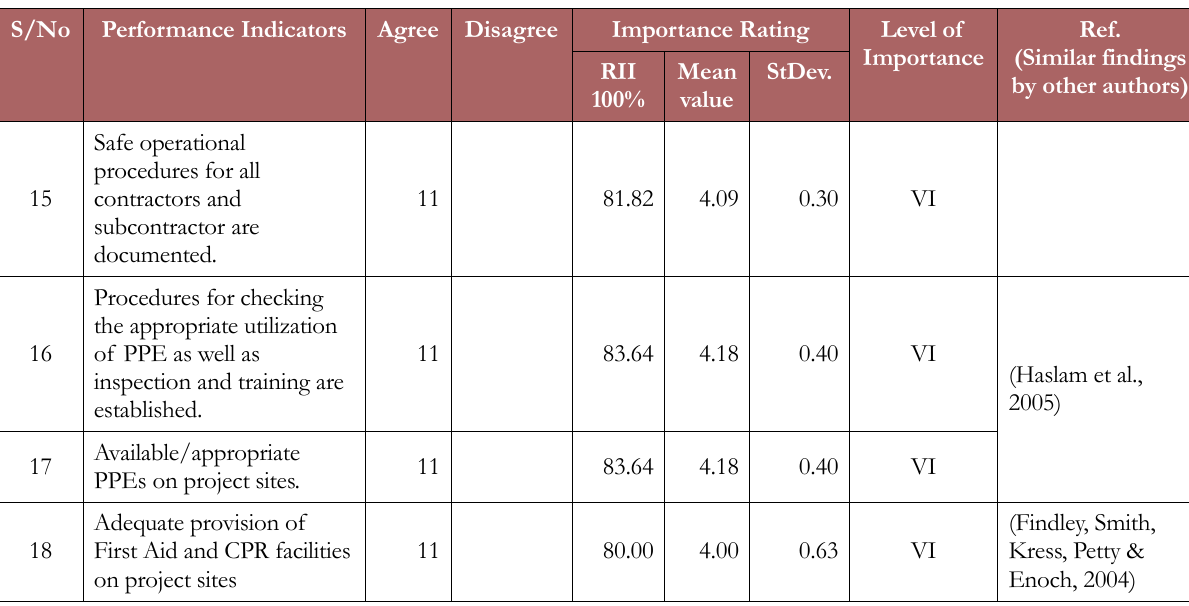
Table 8. Key Performance Indicators for Administration of Safety and